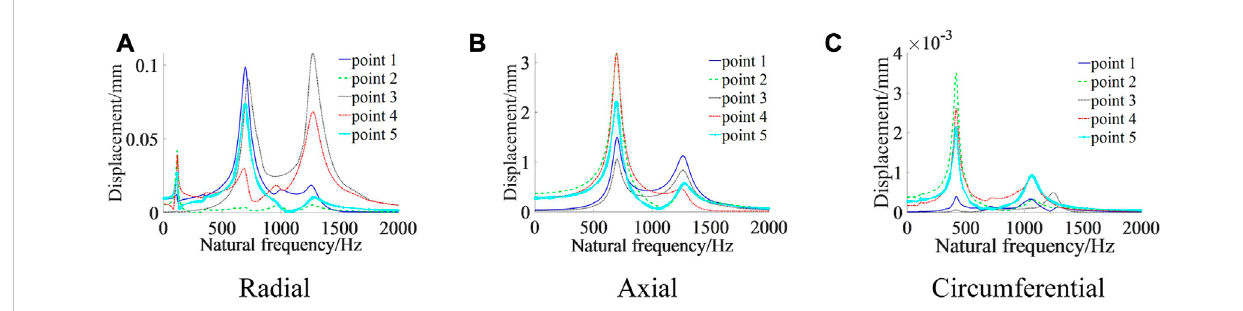
FIGURE 8 Displacement – frequency curve of the measurement point (A – C) .